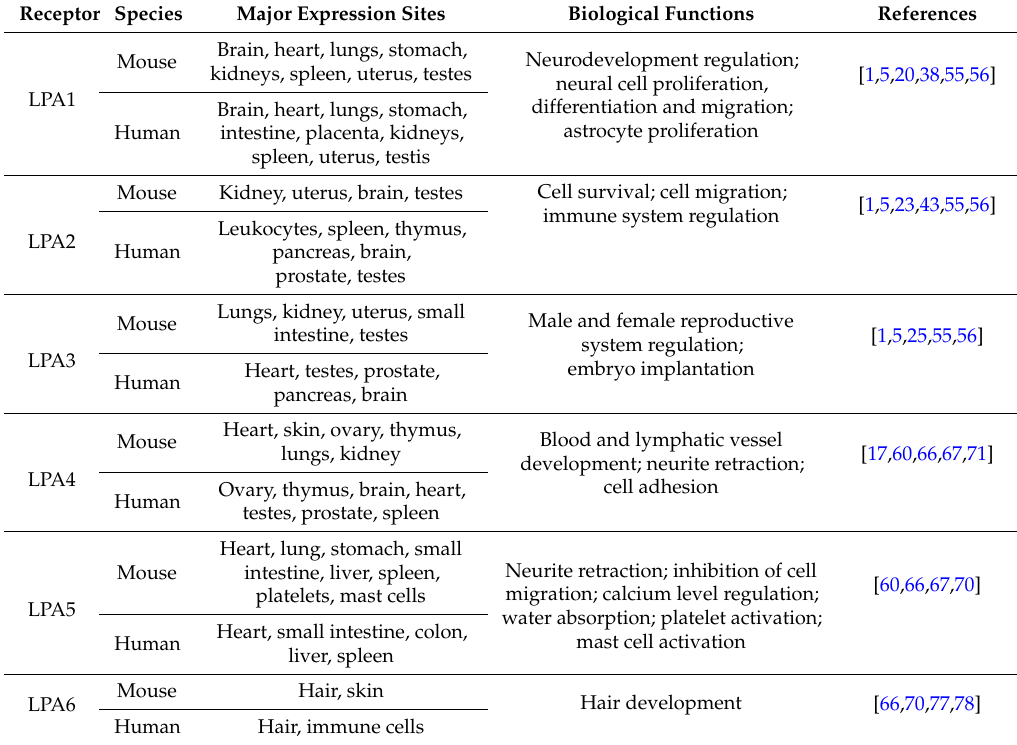
Table 1. Expression pattern of LPA receptors and their known physiological functions in mice and